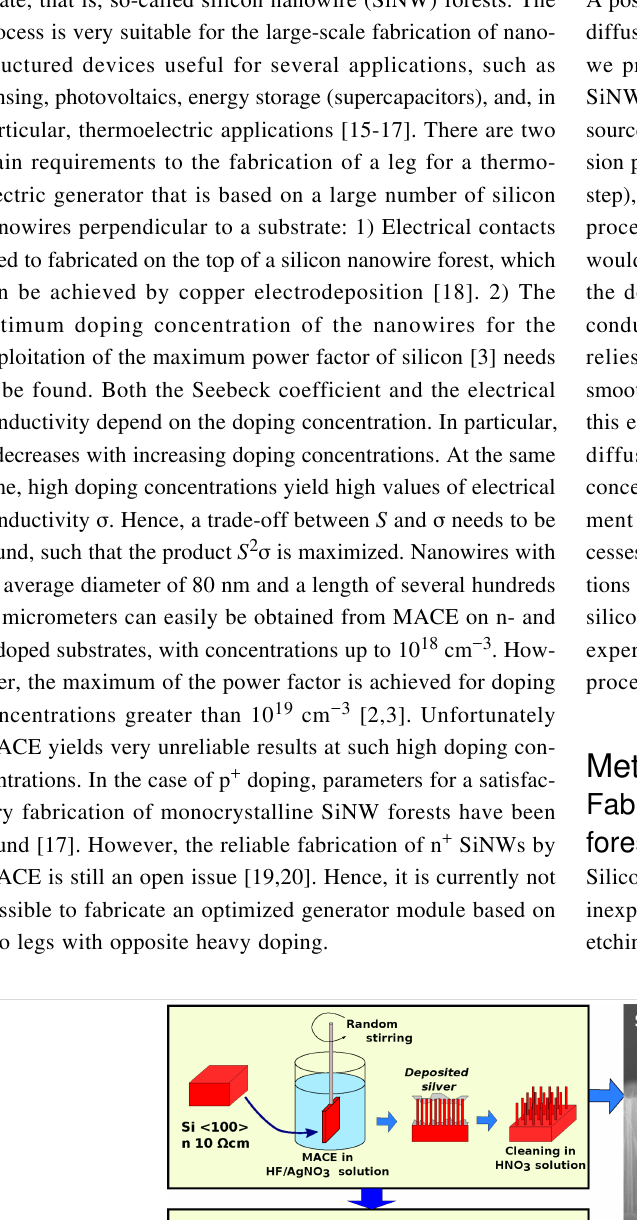
Figure 1: (Left) Schematics of the fabrication process and (right) SEM images of silicon nanowire forests. The forests consist of nanowires with a length of several tens of micrometers, placed perpendicularly to the silicon substrate.